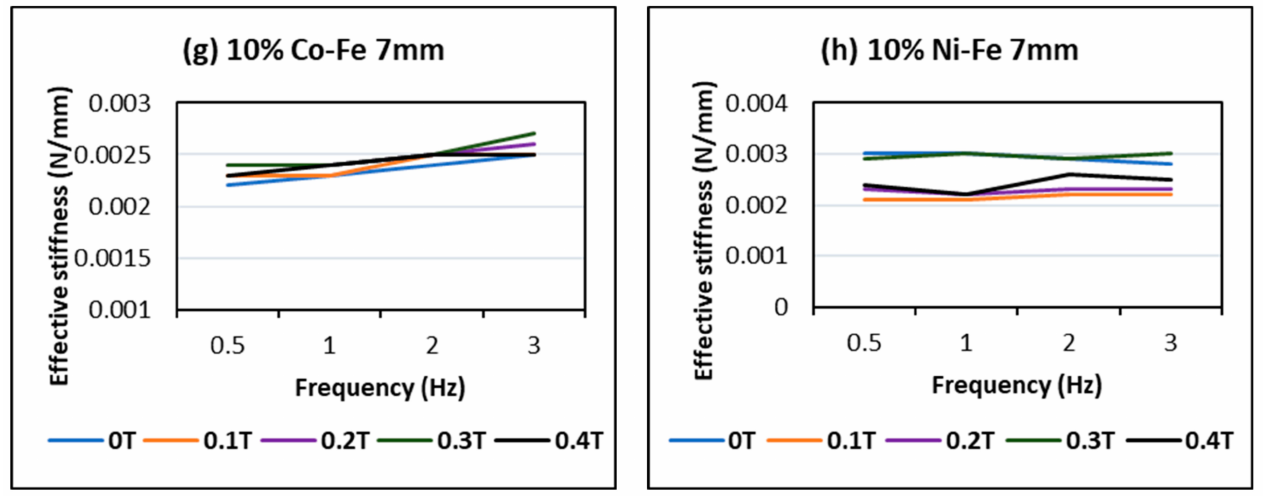
Figure 10. Comparison of % filler content (10, 20, 30 & 40%) between MRE containing Cobalt and Iron ( a , c , e , g ) and MRE having Nickel and Iron ( b , d , f , h ) while simultaneously studying the effect of frequency and magnetic field on effective stiffness.